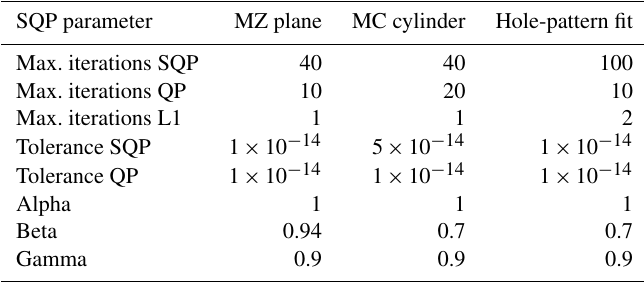
Table B1. SQP method parameters for test